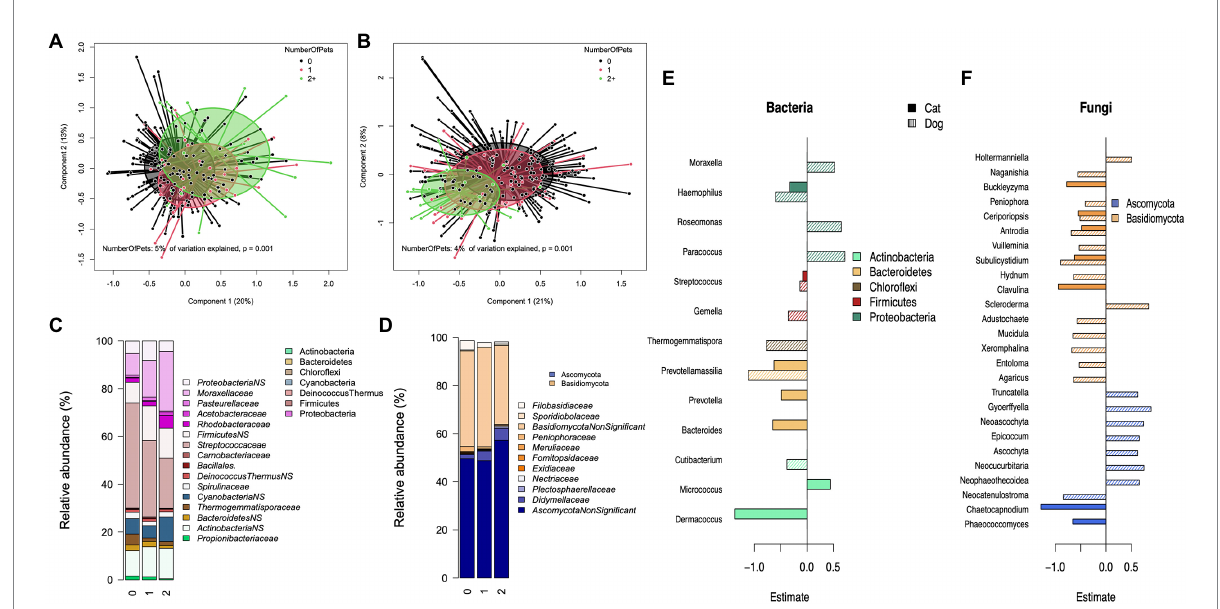
FIGURE 2 The role of the number of dogs in a household and bacterial and fungal composition. Principal coordinate analysis (PCoA) for the genus level composition of (A) bacteria and (D) fungi and grouped by the number of dogs in the home. Mean relative abundance of significantly and non- significantly (NS, p >0.07) associated bacterial (B) , and fungal (E) families by the number of dogs in the home. The estimated effect of the number of dogs, and cats on bacterial (C) and fungal (F)